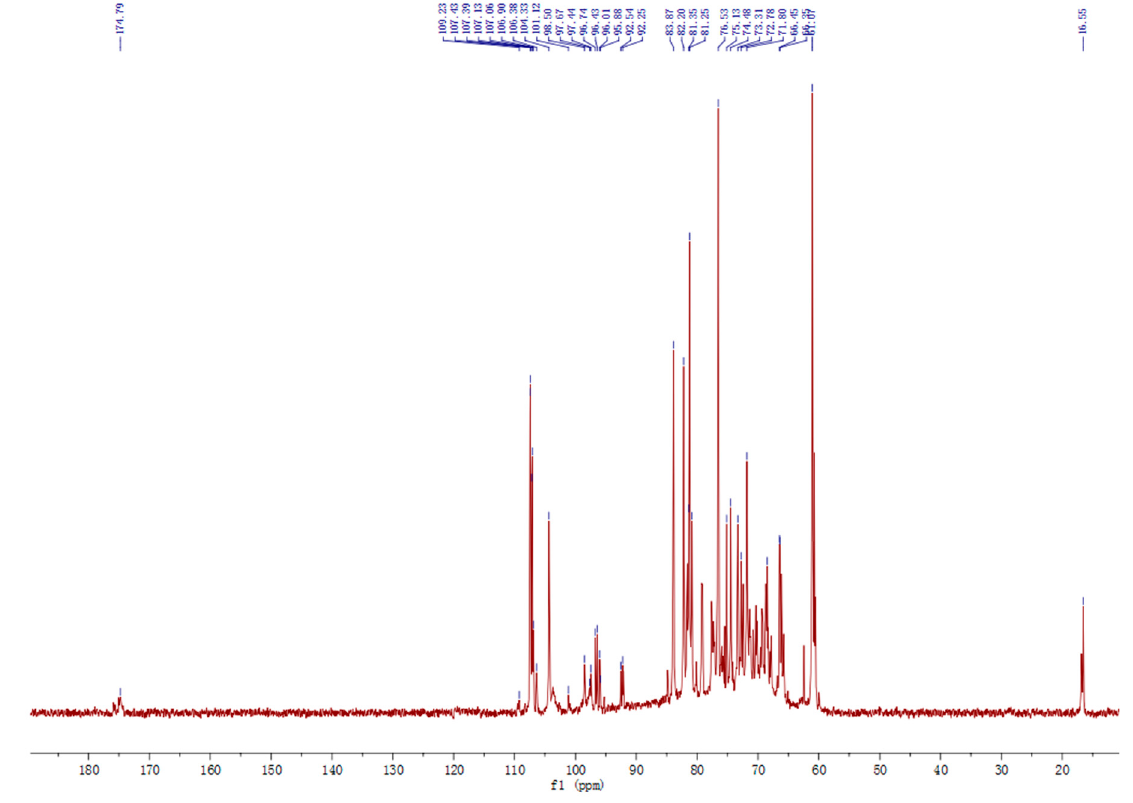
Figure 5. The 13 C-NMR spectra of polysaccharide fraction LCP-I-I.